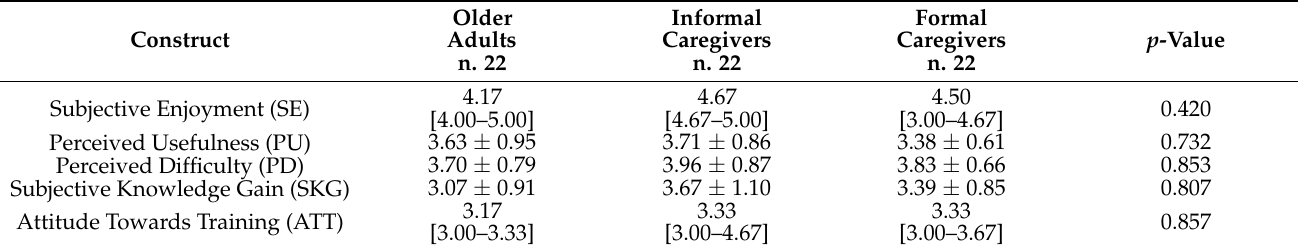
Table 10. Training Evaluation Inventory (TEI 17-items)